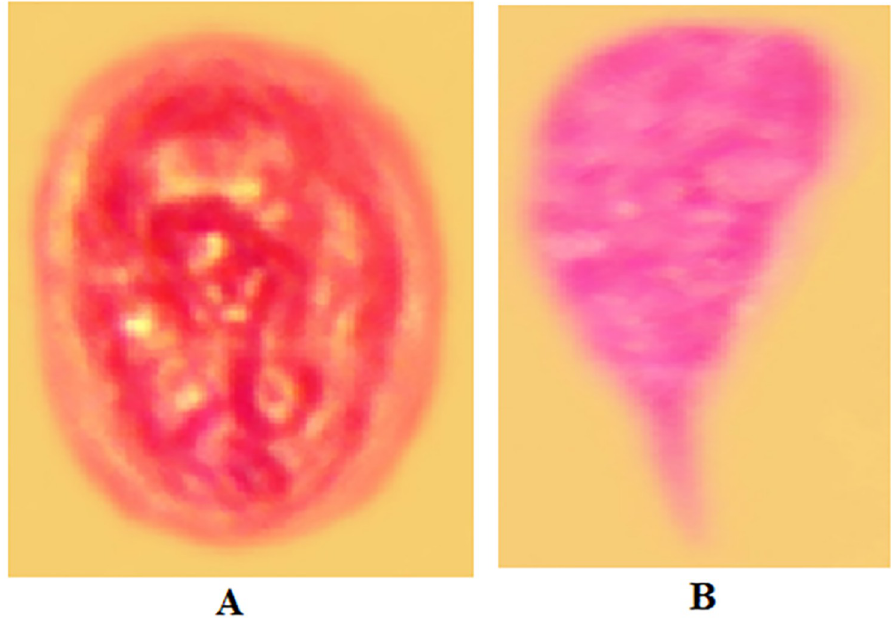
Fig 2. Microscopic examination of G . lamblia using wet mount and formol-ether concentration technique. A, Cyst form; B, Trophozoite form.